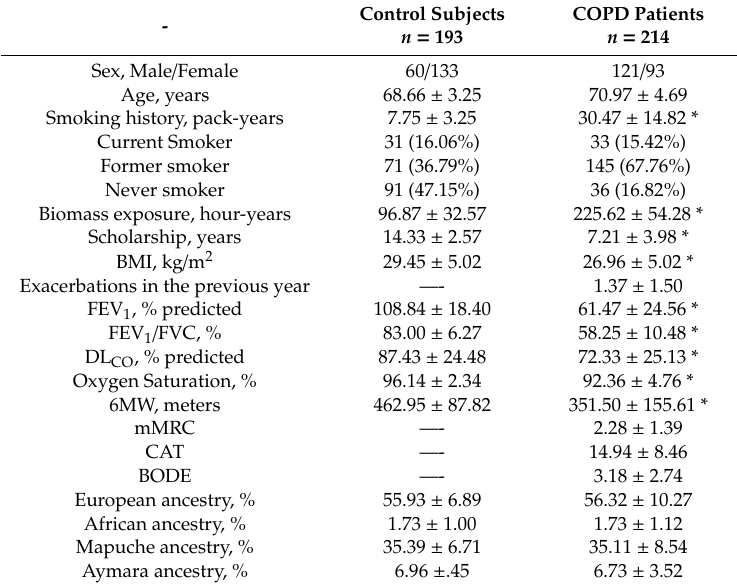
Table 1. Demographic, clinical, and genetic ancestry data of the study population.